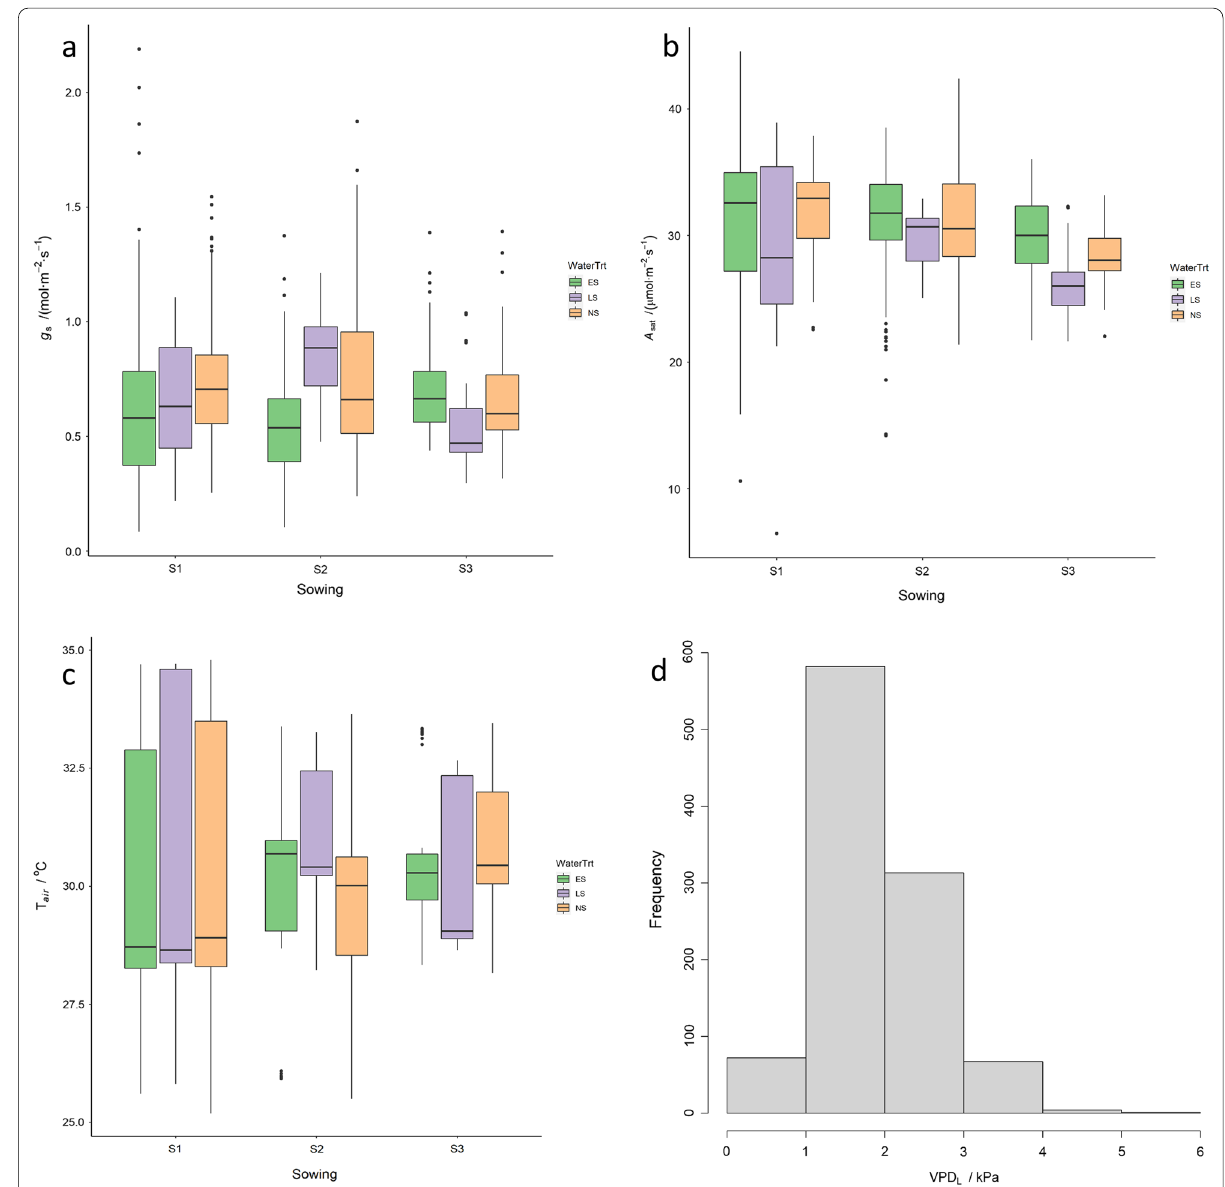
Fig. 2 Variation in a stomatal conductance ( g s ), b photosynthesis ( A sat ), and c air temperature (T air ) for sowing time and water treatments; and d the frequency of gas exchange measurements in different VPD L environments. Sowing dates were 5th October 2011 (S1), 9th November 2011 (S2) and 30th November 2011 (S3), respectively. Water treatments were early limited water (ES, green), late limited water (LS, purple) and non-stressed (NS, orange),